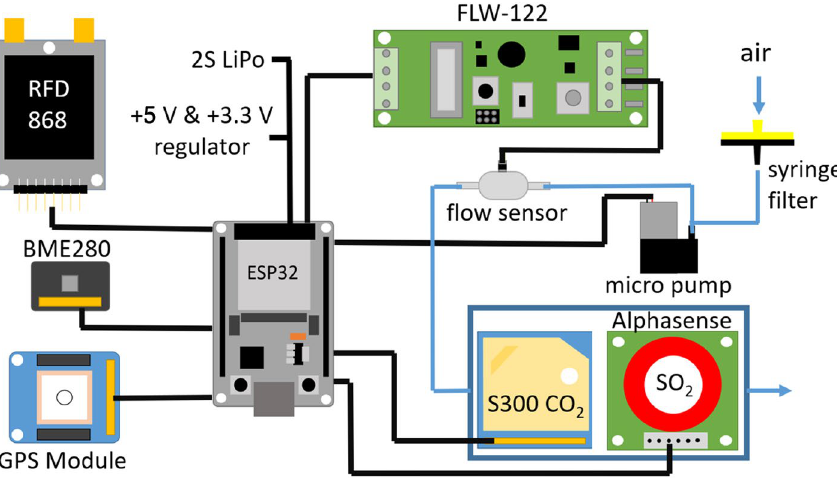
Figure 2. Schematic diagram of the sensor and telemetry system of little-RAVEN.